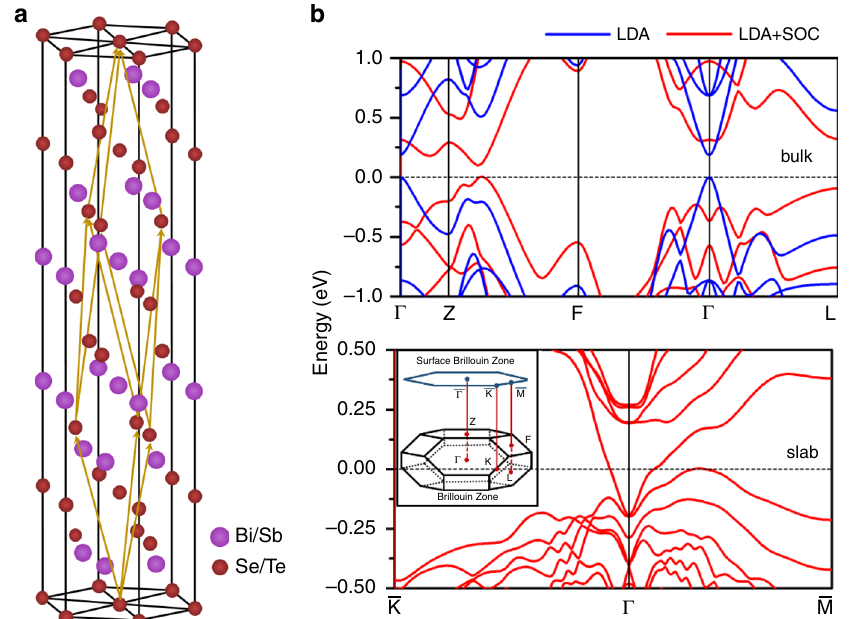
Fig. 1 Topological insulator properties of Bi 2 Te 3 . a Crystal structure of rhombohedral-phase Bi 2 Te 3 . b Band structure of Bi 2 Te 3 bulk (top panel) and slab (bottom panel) calculated at the LDA level, with (red lines) and without (blue lines) spin – orbit coupling. Including the latter leads to band-inversion at the Γ point and gives rise to topologically protected states at the surface (bottom panel). Inset of the bottom panel shows Brillouin zone of the crystal indicating the main symmetry points.